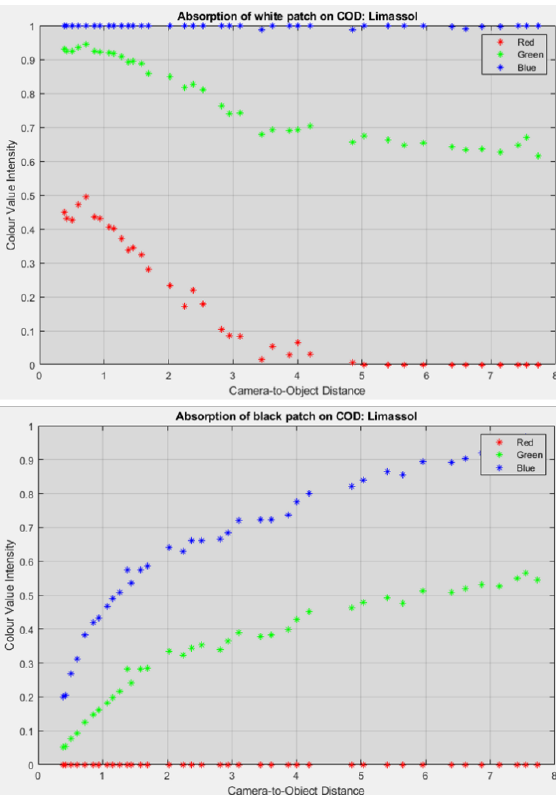
Figure 6. For Limassol dataset: from top to bottom is the colour value behaviour for Red, Green and Blue channels as the camera to object distance increases for the white and black colour patch respectively.